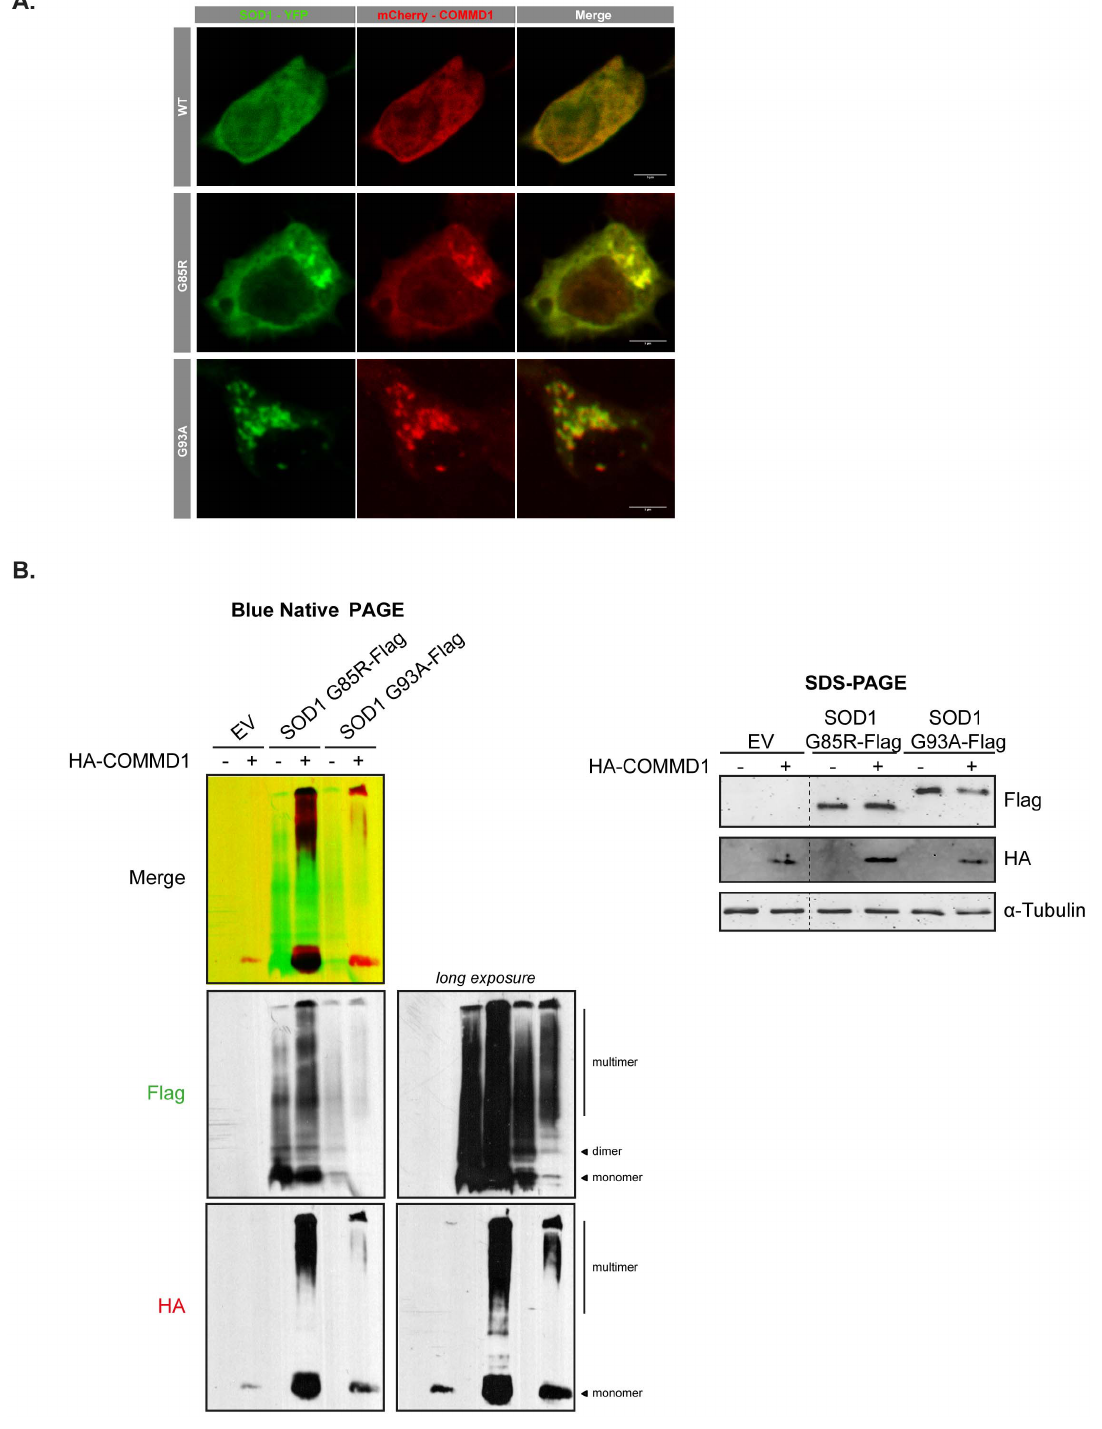
Figure 4. COMMD1 is in complex with aggregated mSOD1 proteins. A. Neuro2A cells were transient transfected with eYFP-tagged SOD1 WT, or mSOD1 G85R and G93A, with or without mCherry-COMMD1, as indicated. 72 h post-transfection, cells were fixed and imaged using a confocal microscope. B . HEK293T cells were transient transfected with either EV (–) or HA-COMMD1 in combination with EV, or Flag-tagged mSOD1 G85R or G93A constructs prior to lysis and detection of SOD1 multimeric complexes using blue native PAGE (30 m g). Immunoblotting was performed using antibodies directed against the Flag-tag and HA-COMMD1 proteins. Total protein levels were analysed in presence of b -ME on a SDS-PAGE gel (30 m g). Photoshop analysis was used to generate overlay, using a marked region on the membrane as focus point.